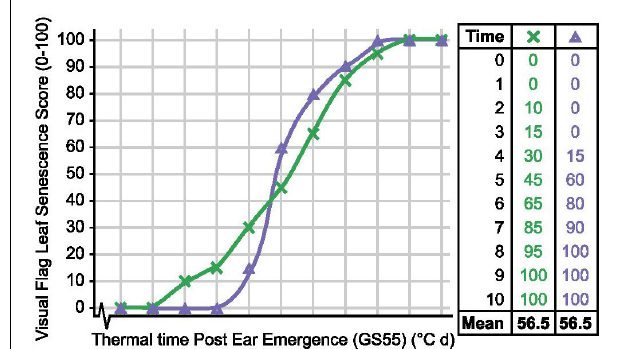
FIGURE 8 | Mean senescence scores cannot always distinguish senescence variation. Senescence duration of line × (green) is prolonged, while onset of senescence is delayed and senescence rate is rapid for line (cid:49) (purple), but their mean senescence scores are the same.